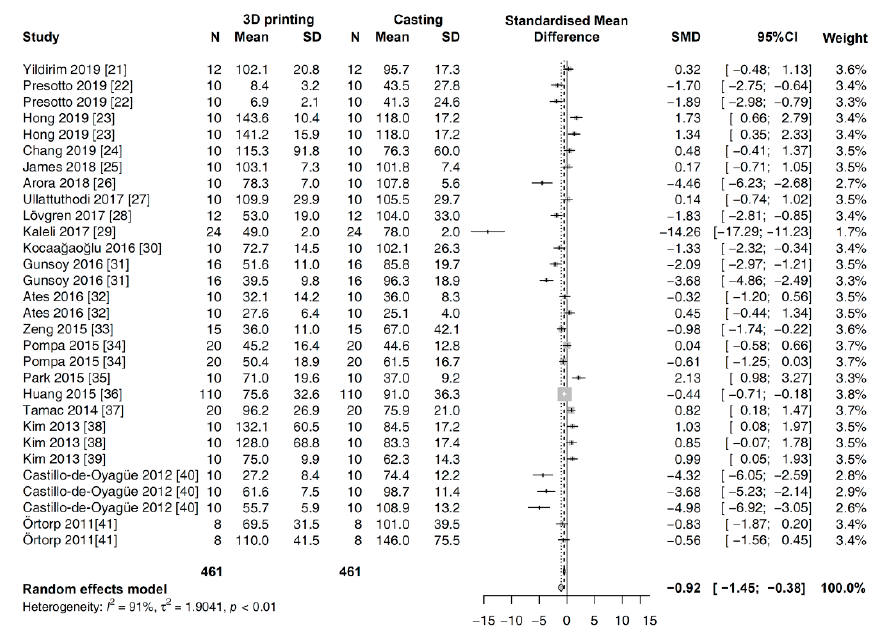
Figure 3. Global meta-analysis on the marginal gap of prostheses fabricated with 3D printing versus casting methods.